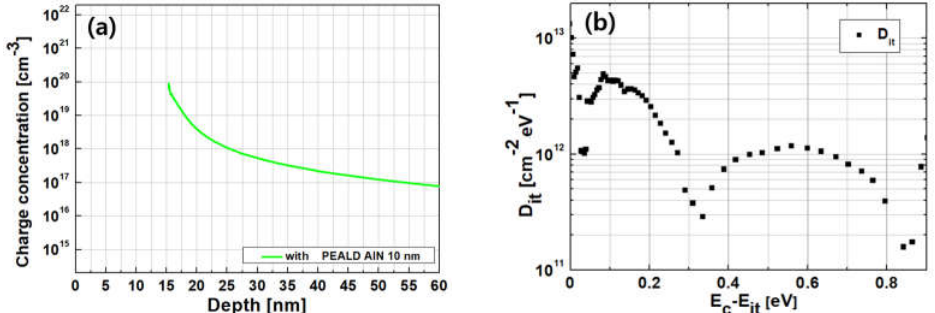
Figure 5. ( a ) Carrier distribution versus depth and ( b ) interface trap density extracted by Terman method.